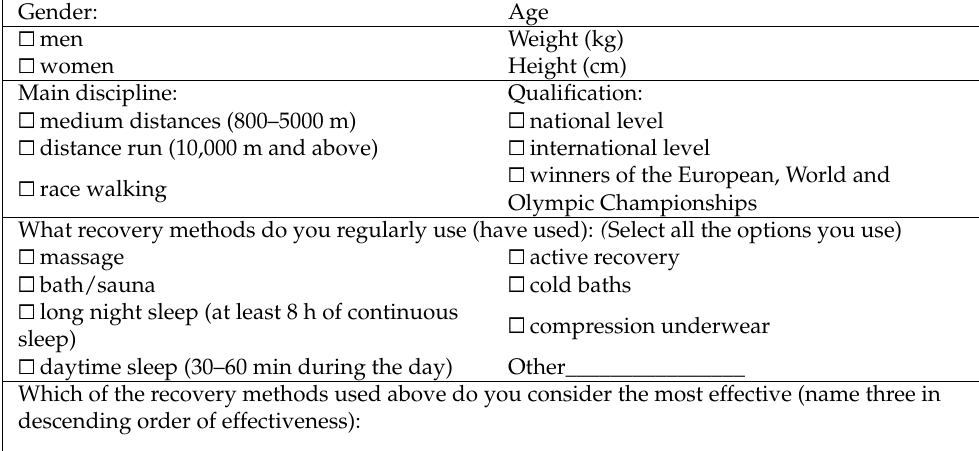
Table 1. The questionnaire “Methods of recovery among highly competitive athletes training. En- durance”.